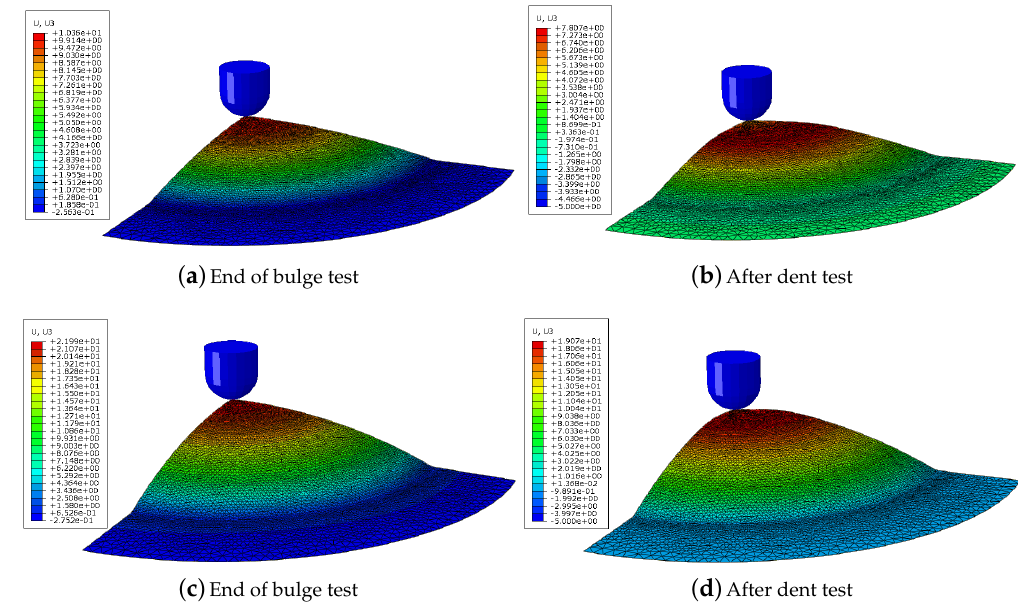
Figure 12. Numerical deformed geometries. Pre-strain intensity (cid:101) xx = 0.02 for ( a , b ), and (cid:101) xx = 0.07 for ( c , d )